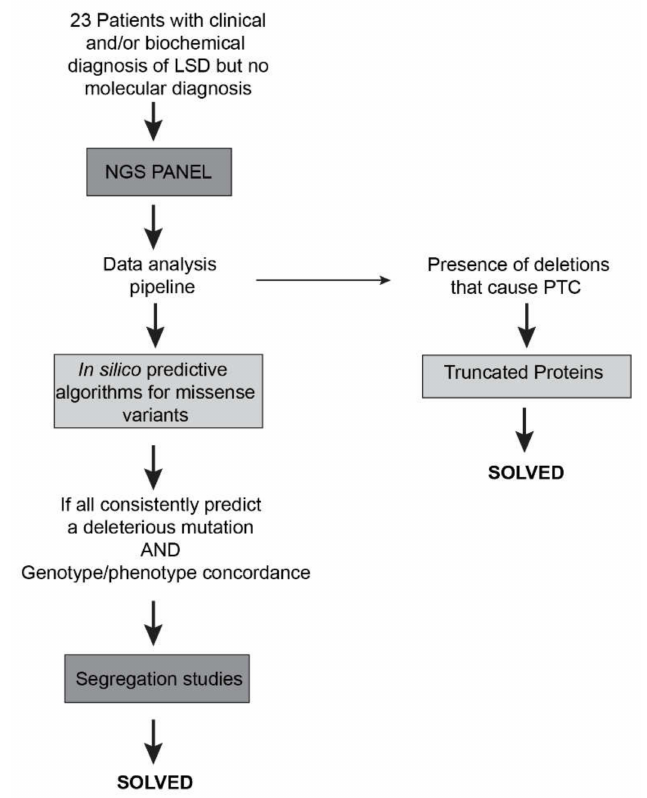
Figure 2. Workflow of the study of the patients and respective molecular characterization The NGS-targeted gene panel allowed the identification of four novel and six previously identified pathogenic variants in a group of 23 patients. PTC = premature termination